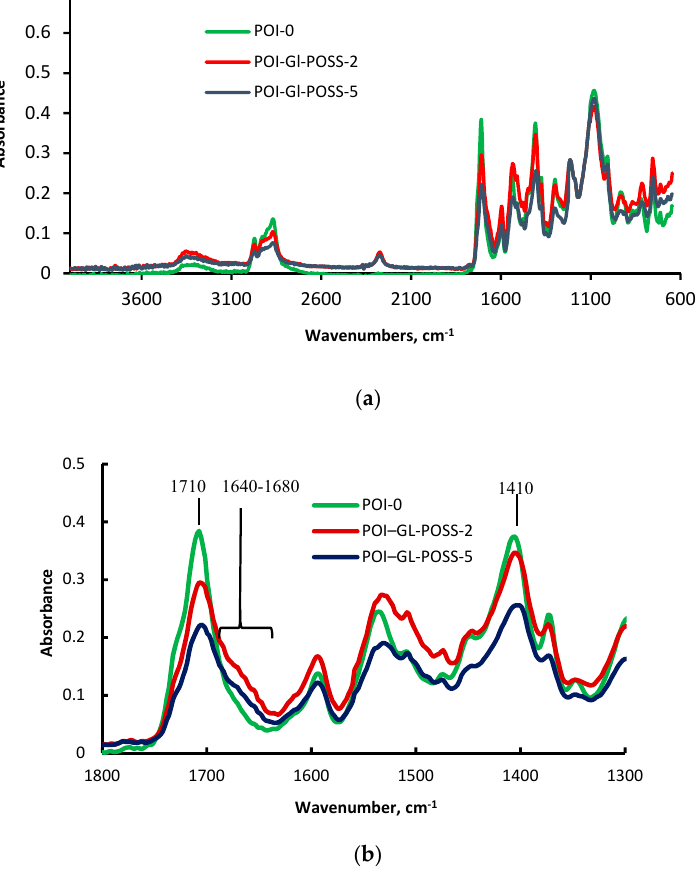
Figure 2. FTIR spectra of POI and POI-Gl-POSS ( a ) 3600–600 cm − 1 , ( b ) 1800–1300 cm − 1